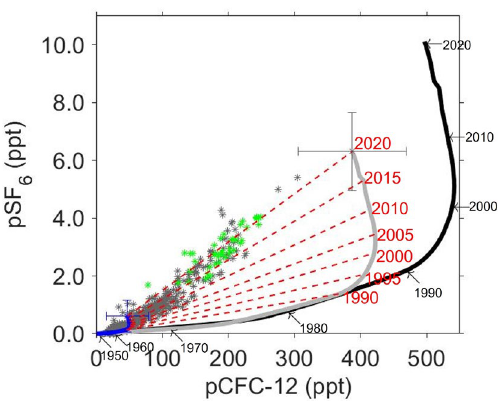
Figure 4. Relationship between observed pCFC-12 and pSF 6 in AABW. Green and dark gray asterisks indicate new AABWs along Wild Canyon (neutral density: γ n > 28.27 kg m −3 , θ < − 0.4 °C) 10 and the other AABWs ( γ n > 28.27 kg m −3 ), respectively. Black line and black numbers indicate the year-to-year variations in atmospheric partial pressure and the year, respectively. Blue and gray lines indicate the year-to-year variations in LCDW and DSW, respectively. Blue and gray crosses show the averages and standard deviations of the estimated LCDW and DSW in 2020, respectively. Red dashed lines and red numbers indicate the estimated year-to-year linear relationship of AABW and the year,